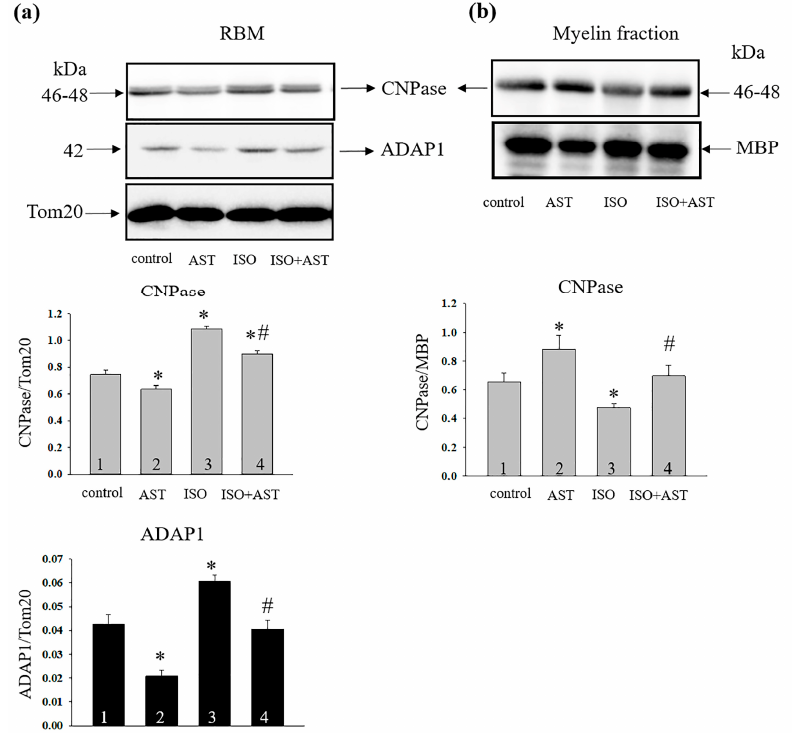
Figure 5. The effects of AST and ISO on the level of CNPase and ADAP1 in RBM. The immunodetection of Tom 20 and MBP was used for protein normalization. ( a ) (Upper part)—immunostaining with antibodies to CNPase, ADAP1, and Tom20; (lower part)—quantification of immunostaining by computer-assisted densitometry presents as a ratio in the level of proteins to Tom20. ( b ) (Upper part)—immunostaining with antibodies to CNPase and MBP in myelin fraction; (lower part)—quantification of immunostaining by computer-assisted densitometry presented as a ratio in the content of protein to MBP. The data are presented as the means ± SDs of five independent experiments. * p < 0.05 a significant difference in the protein level in comparison with the control (group 1). # p < 0.05 a significant difference compared to ISO alone (group 3).